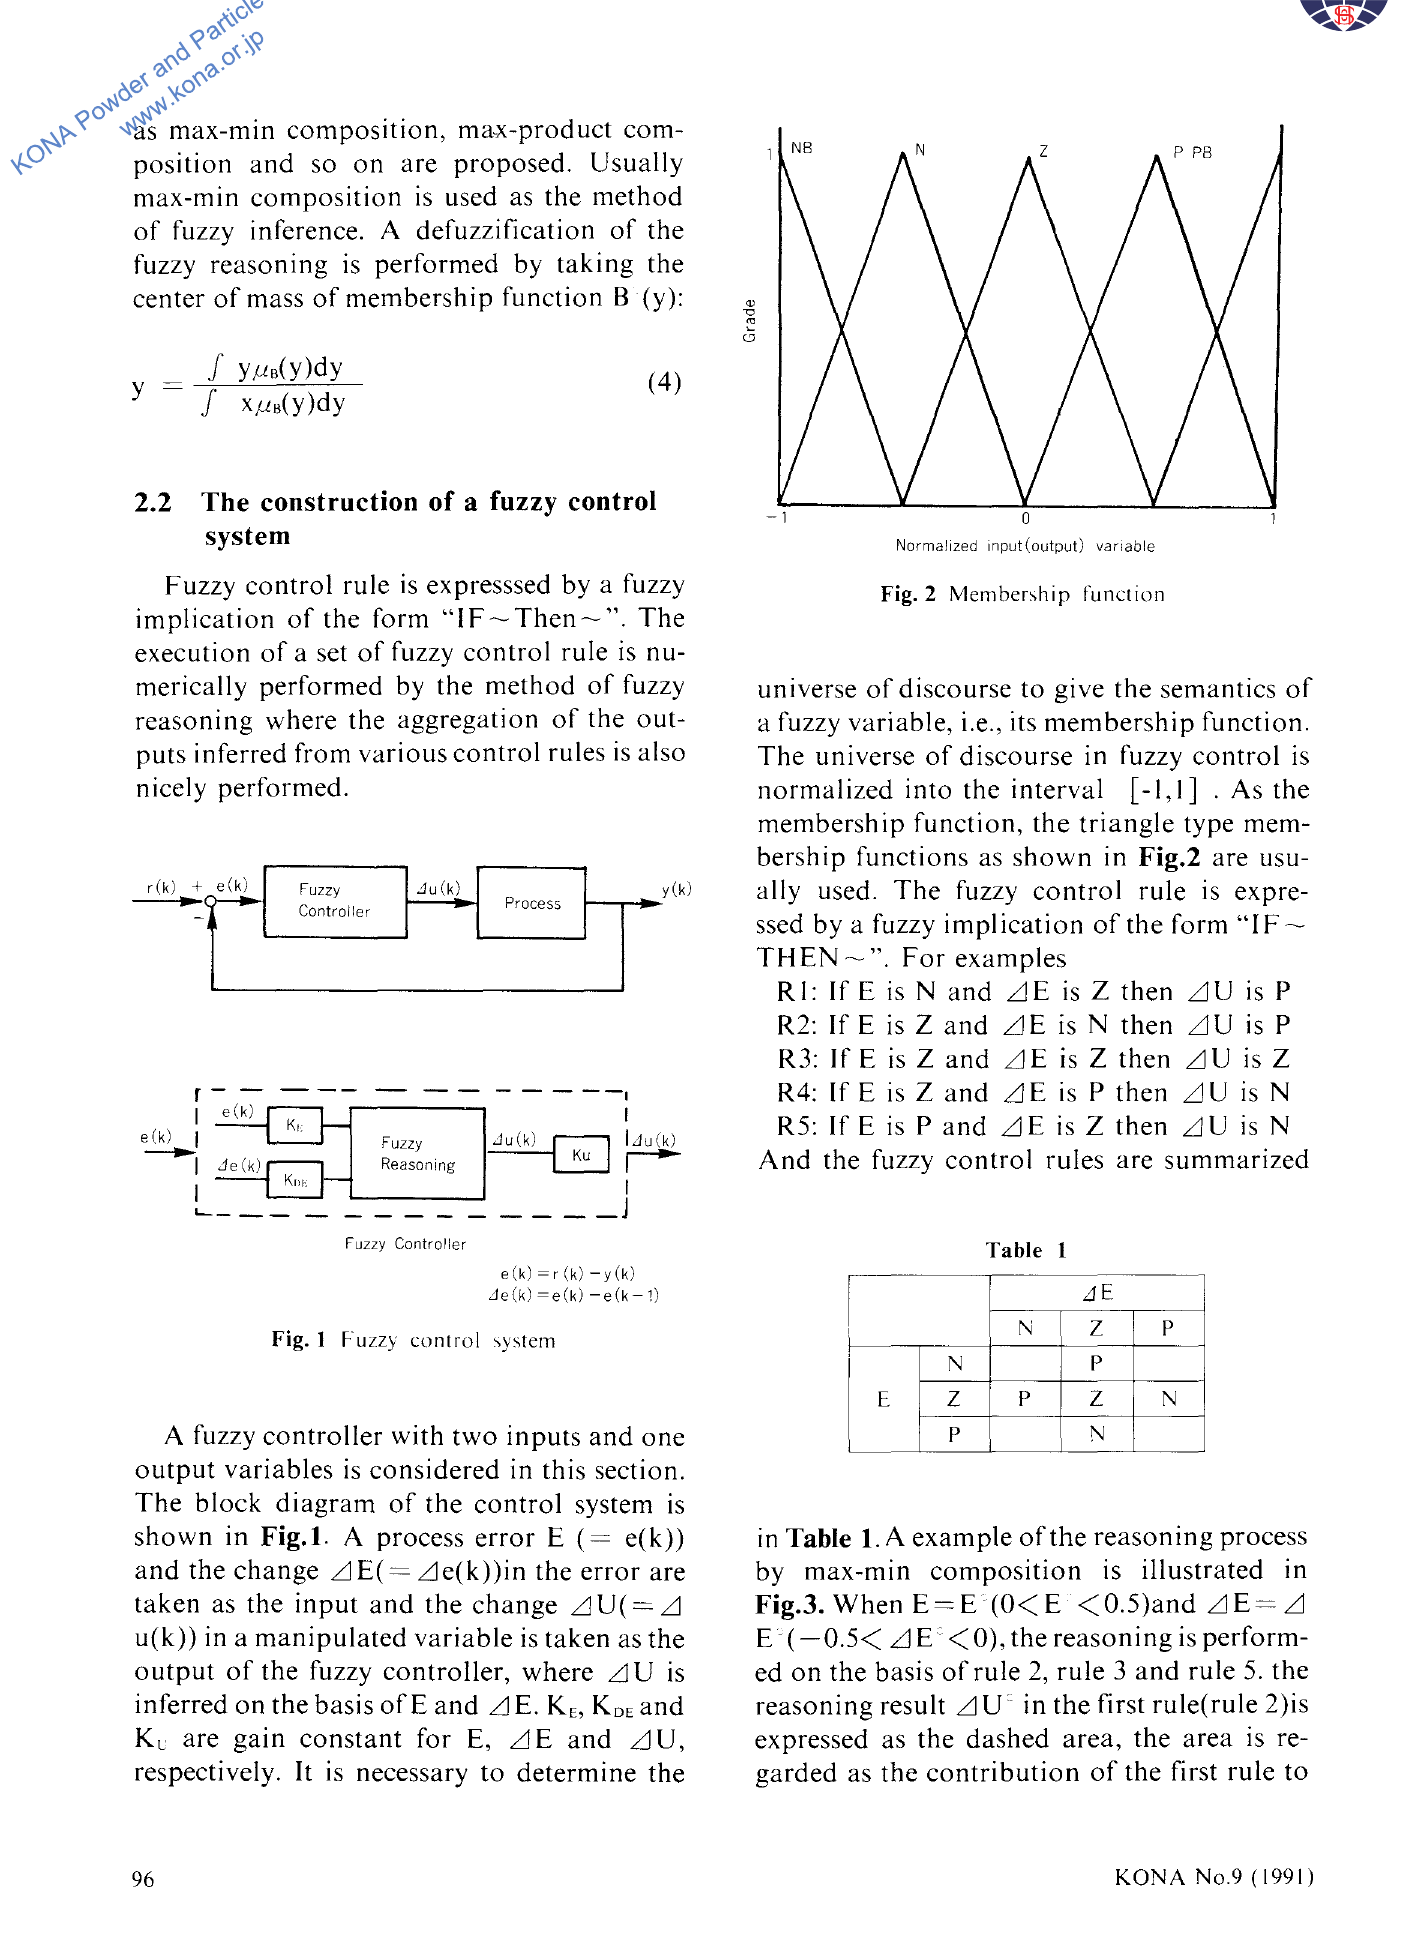
Fig.3. When E=E (O<E <0.5)and